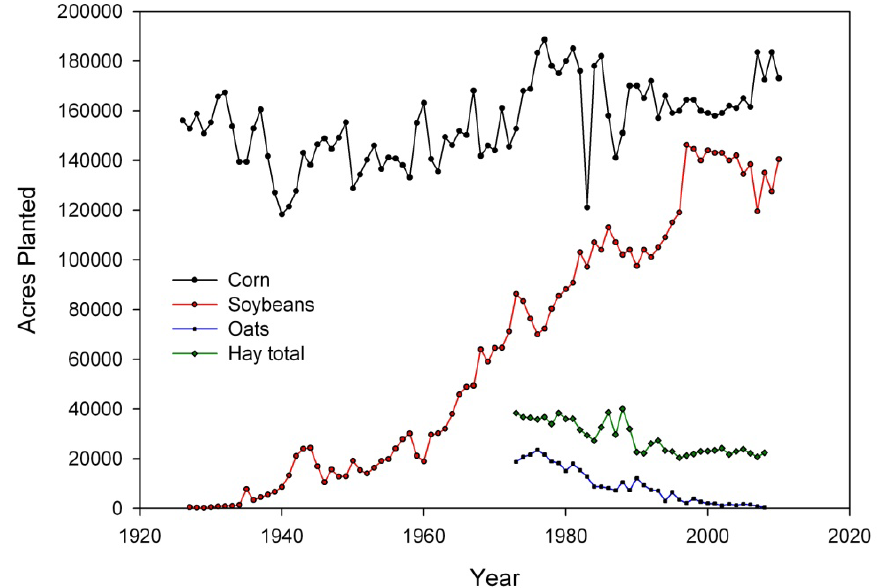
Figure 2. Changes in crop production in Jasper County,